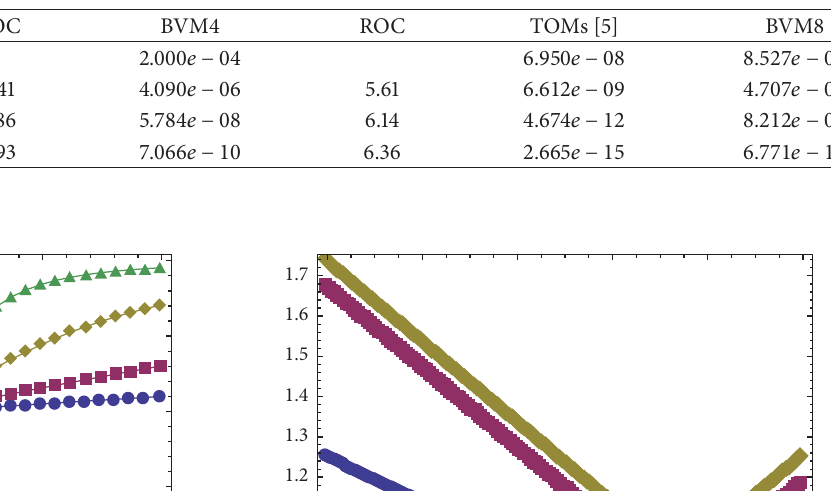
Table 8: Maximum Errors for different stepsizes for Example 5 for 𝜆 = 0.1 .